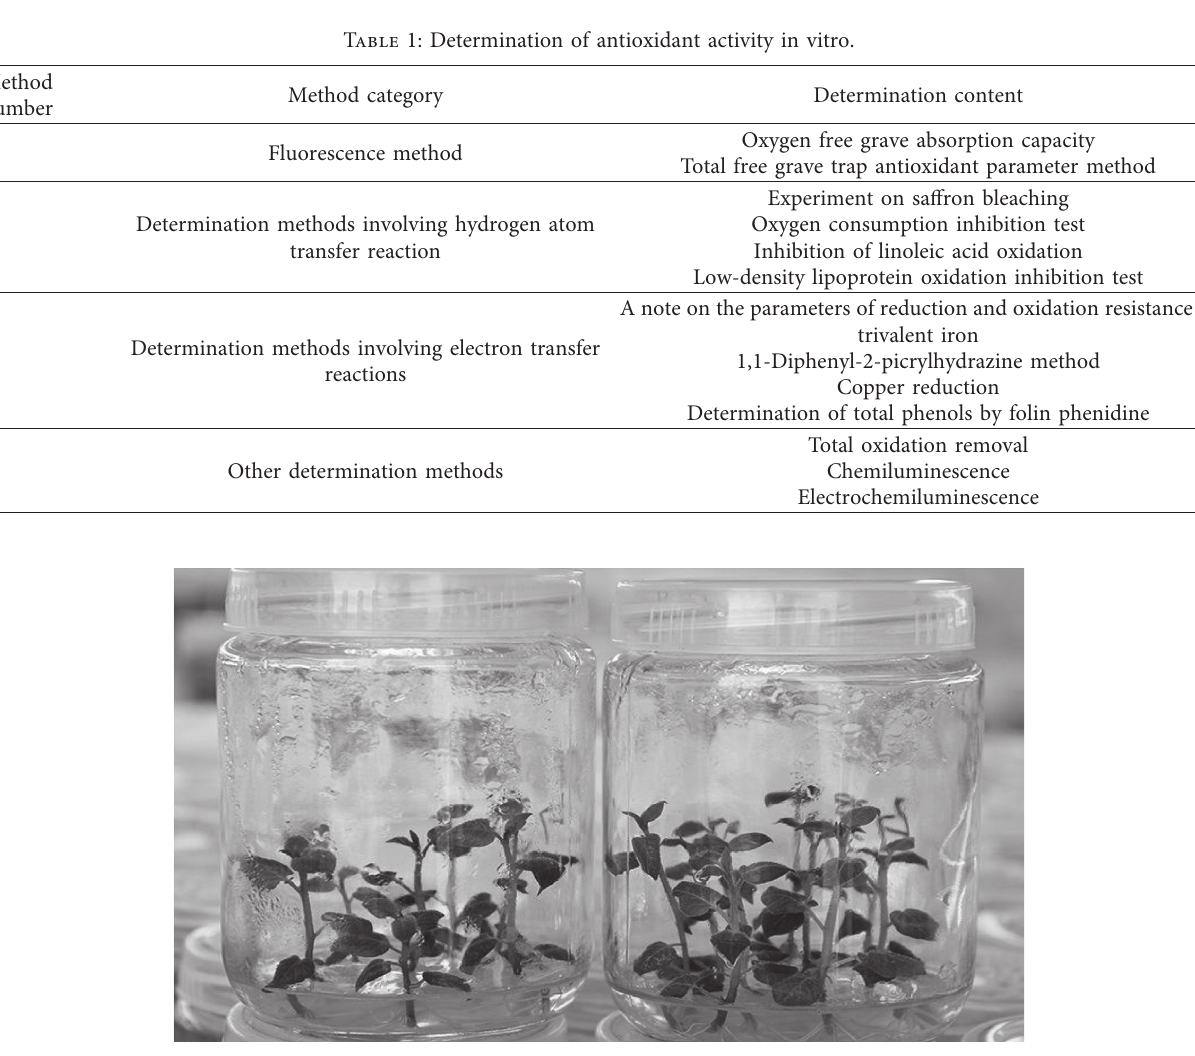
Figure 1: Potato seedling